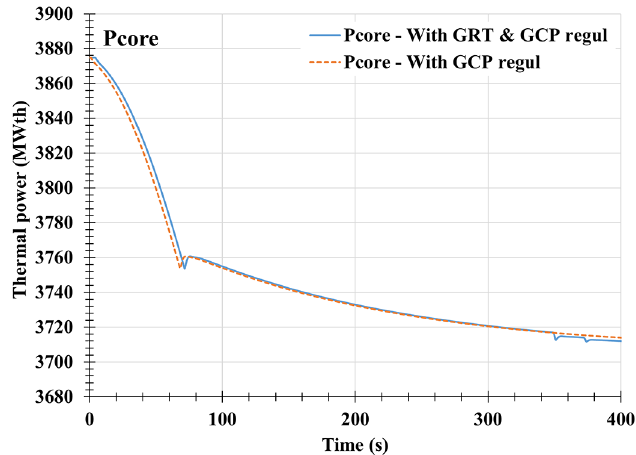
Fig. 5. Thermal core power during load following according to the